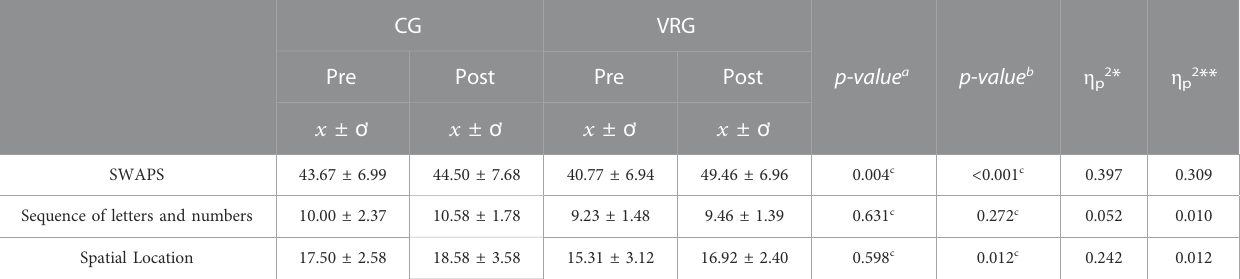
TABLE 4 Group differences across time in processing speed